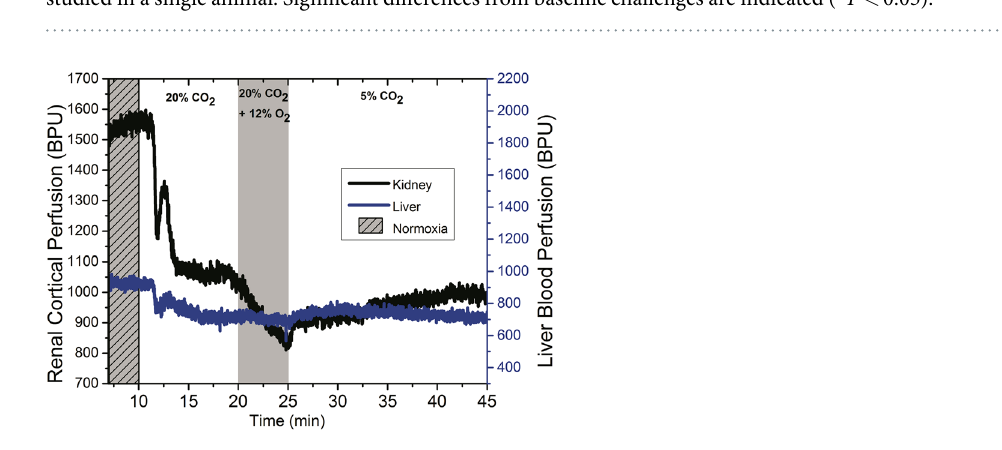
Figure 7. Laser Doppler perfusion response to gas challenges. Mean changes in blood perfusion units in the liver and kidney cortex for different gas challenge regimes averaged across all animals ( N = 5 per group) and standard error are shown for the liver and kidney cortex. Exceptions are 5% CO 2 and 12% O 2 , which were studied in a single animal. Significant differences from baseline challenges are indicated ( * P < 0.05).